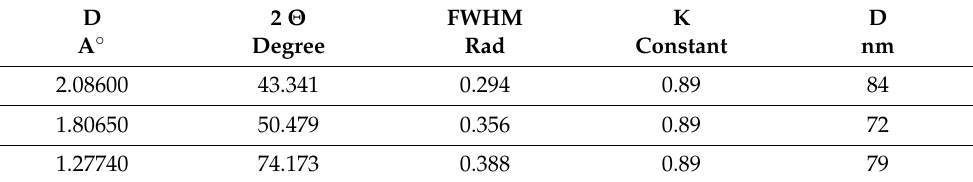
Table 2. Calculation of the crystallite size of Cu-NPs.